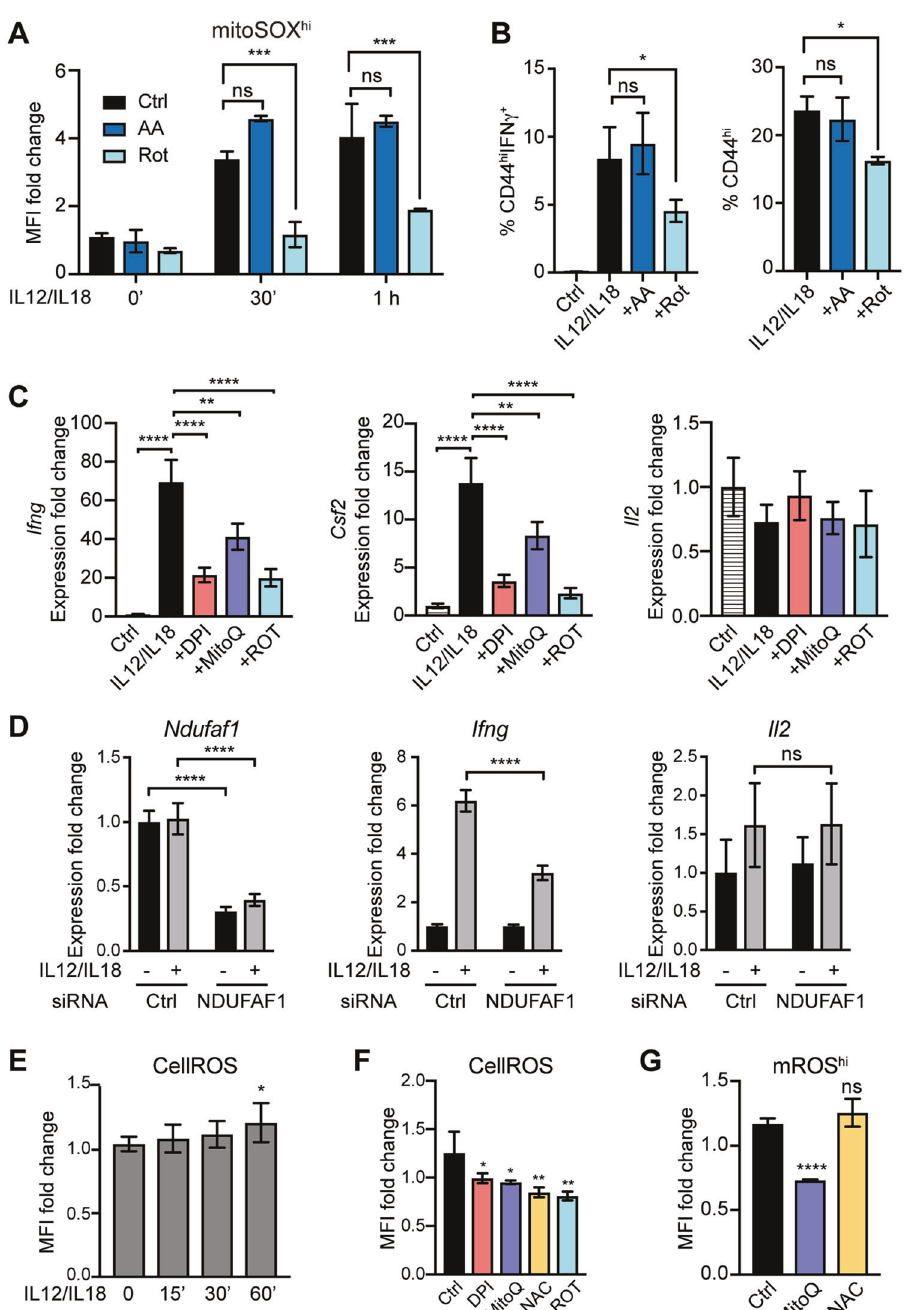
Fig. 3 The effect of different inhibitors on IL-12/IL-18-triggered IFN- γ production in differentiated memory-like CD4 + T cells. In vitro differentiated memory-like CD4 + T cells (as in Fig. 1) were stimulated with IL-12/IL-18. A mROS production in mitoSOX hi population was reduced by rotenone treatment but not by antimycin A. B Effect of rotenone and antimycin A treatment on IFN- γ -production and CD44 expression by CD4 + cells. Data were obtained by fl ow cytometry. C qRT-PCR analysis of IFN- γ , GM-CSF (Csf2) and IL-2 expression in memory- like cells at 1 h after treatment with IL-12/IL-18 or IL-12/IL-18 plus inhibitors (DPI, rotenone) or MitoQ. D qRT-PCR analysis of NDUFAF1, IFN- γ , and IL-12 expression in siCtrl or siNDUFAF1-transfected memory-like CD4 + T cells after treatment with IL-12/IL-18. E Flow cytometry analysis of cellular ROS production after IL-12/IL-18 treatment. Flow cytometry analysis of CellROS ( F ) and mROS G production in memory-like cells stimulated with IL-12/IL-18 (Ctrl) or IL-12/IL-18 plus inhibitors (DPI, rotenone) or antioxidants (MitoQ, NAC). The samples for qRT-PCR, cellROS and mROS measurement were normalized to unstimulated cells of each treatment condition. Graphs show mean ± SD ( n = 3 different mice); * p < 0.05; ** p < 0.01; *** p < 0.001; **** p < 0.0001; ns, not signi fi cant; two-way ANOVA with Sidak ’ s correction A , D ; one-way ANOVA with post- hoc Tukey test B , C , E , F , G